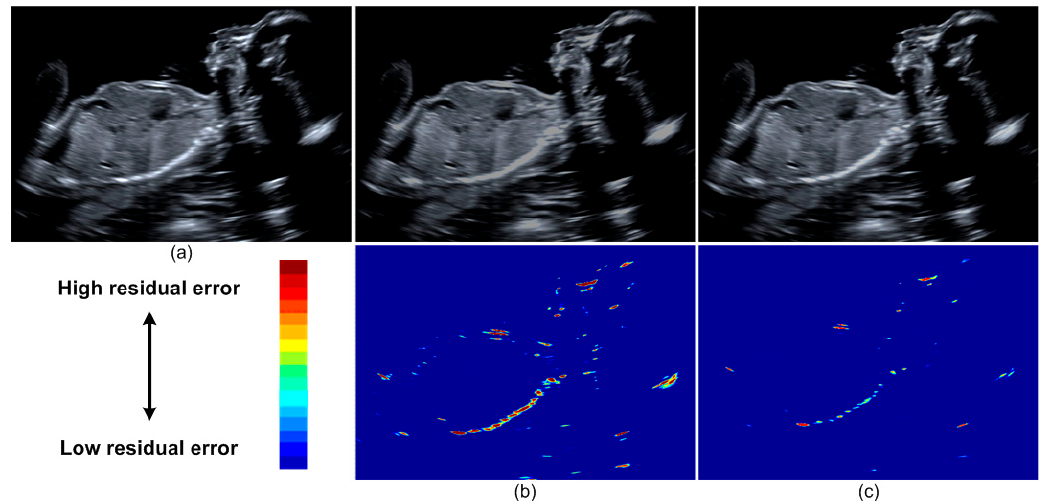
Figure 5. Quality comparison for the 7 th image of the 2 nd ultrasound image set: ( a ) original image, ( b ) images generated by I 2 GEC (PSNR: 30.076 dB, Power: 0.931 W), and ( c ) images generated by the proposed algorithm (PSNR: 36.694 dB, Power: 1.261 W) (top: result image; bottom: difference between the original and processed images).